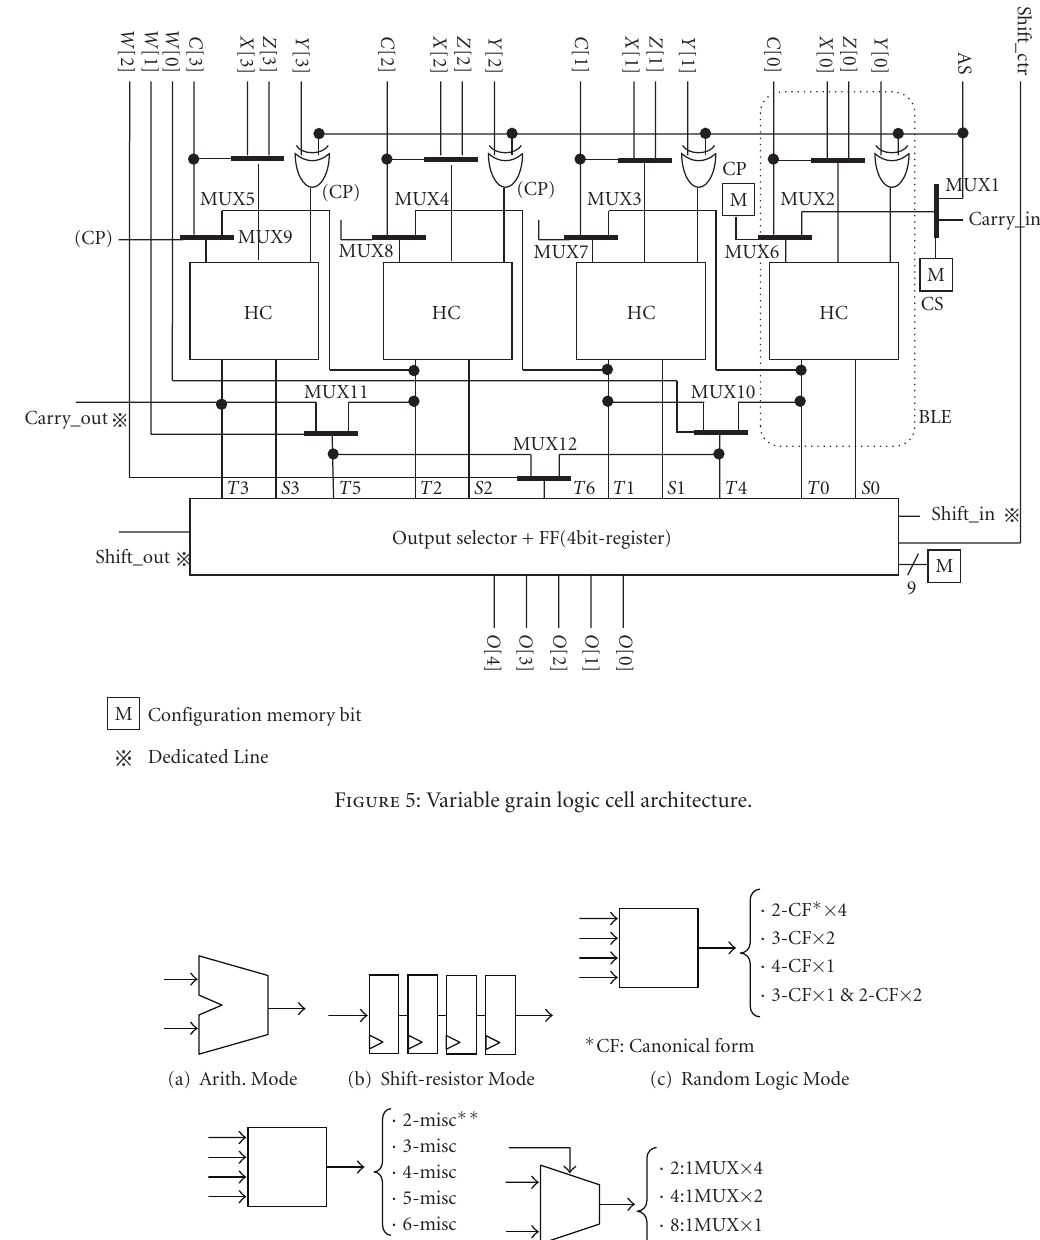
Figure 6: Basic function of a